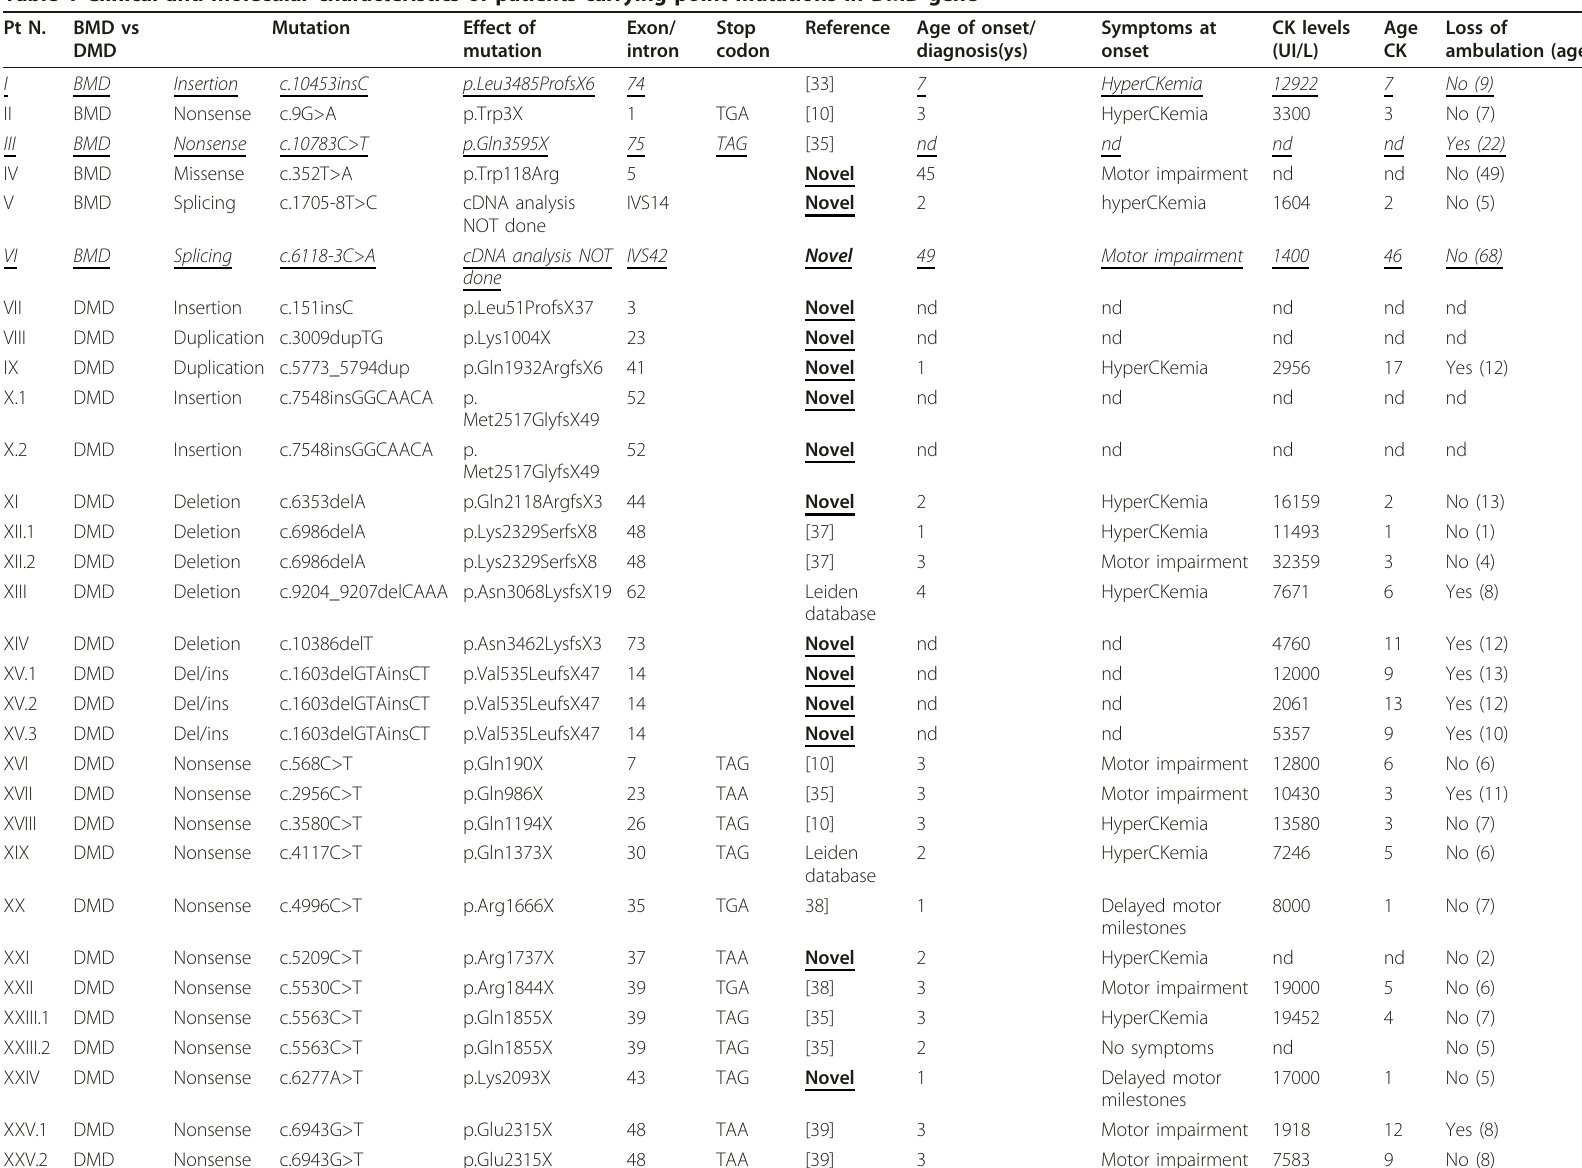
Table 1 Clinical and molecular characteristics of patients carrying point mutations in DMD gene Pt